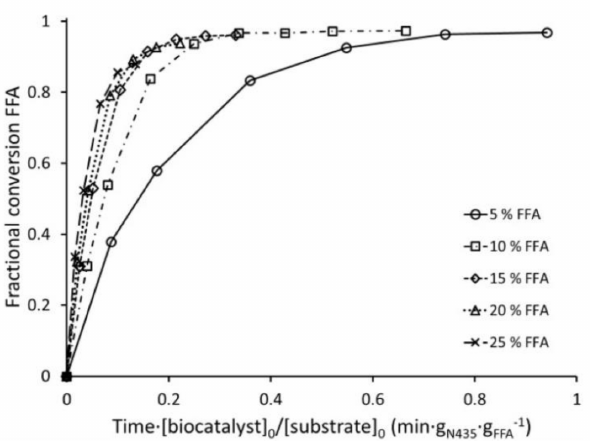
Figure 5. Effect of oleic acid (free fatty acids (FFA)) concentrations ( v / v ) in the esterification of methanol in vegetable oil at 45 ◦ C using 5% ( w / v ) CalB immobilized lipase (reproduced from [2] with permission from